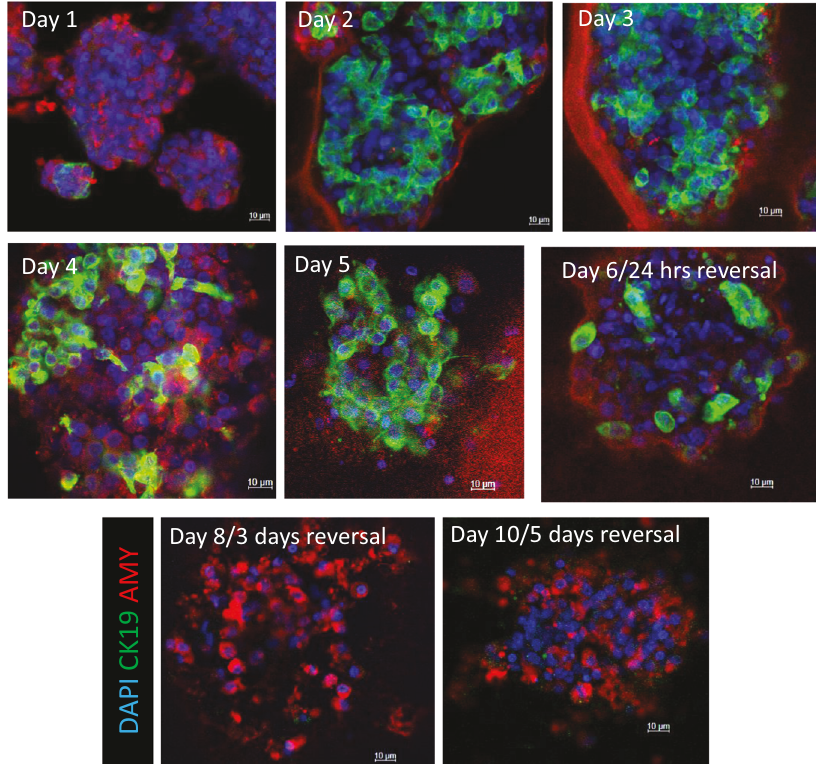
Fig. 7 Reversal of ADM by TSA in primary human acinar cultures. Primary, human acini were cultured in Matrigel on glass chamber slides for 5 days. On day 5 of culture, 500 nM of TSA was added and the cells were cultured for 5 additional days. The cells were processed for immunohistochemistry and imaged for amylase (red) and KRT19 (green) using confocal microscopy.